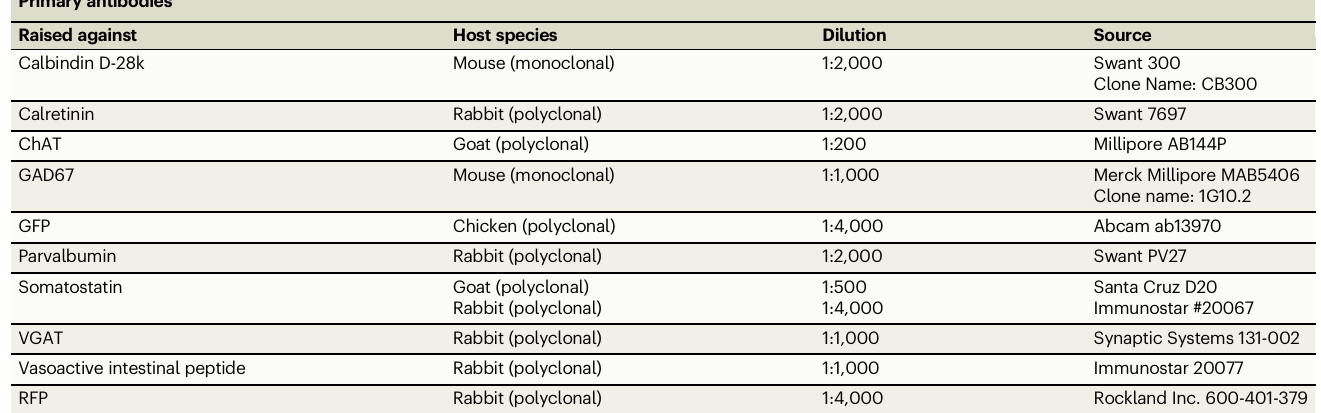
Table 2 | Details of the primary antibodies used Primary antibodies Raised against